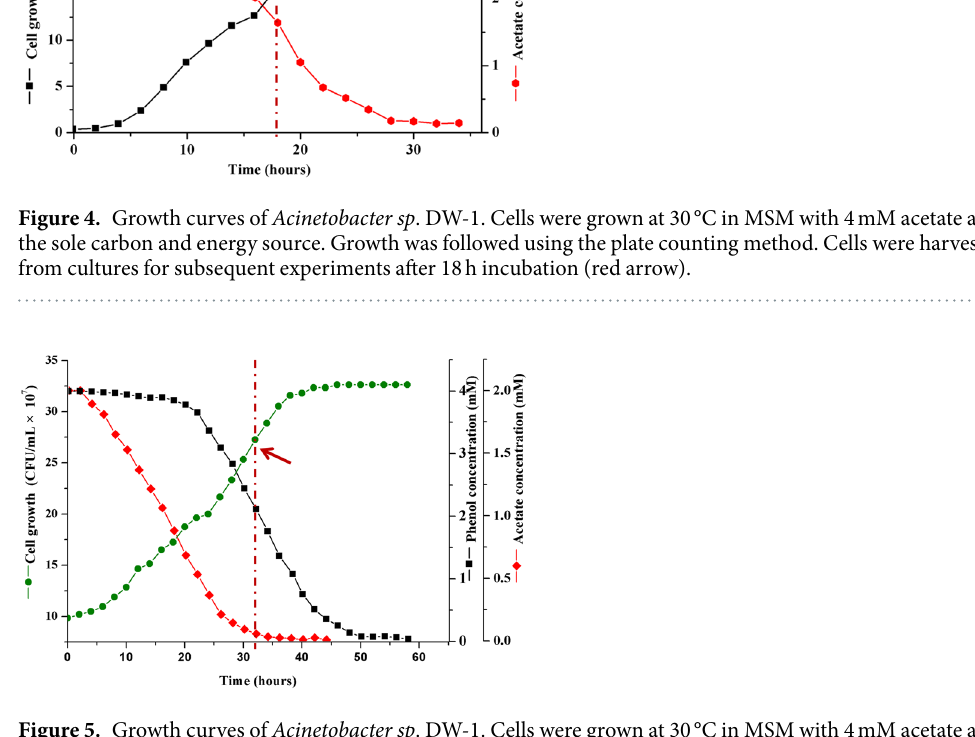
Figure 5. Growth curves of Acinetobacter sp . DW-1. Cells were grown at 30 °C in MSM with 4 mM acetate and 4 mM phenol. Growth was assessed using the plate counting method. Cells were harvested from cultures that after 32 h incubation (red arrow) following phenol supplementation for subsequent